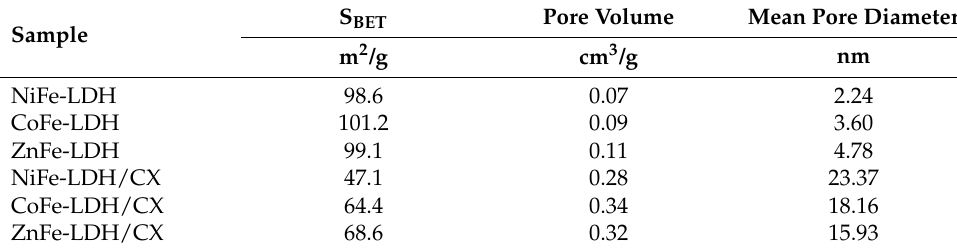
Table 2. Textural data of the prepared